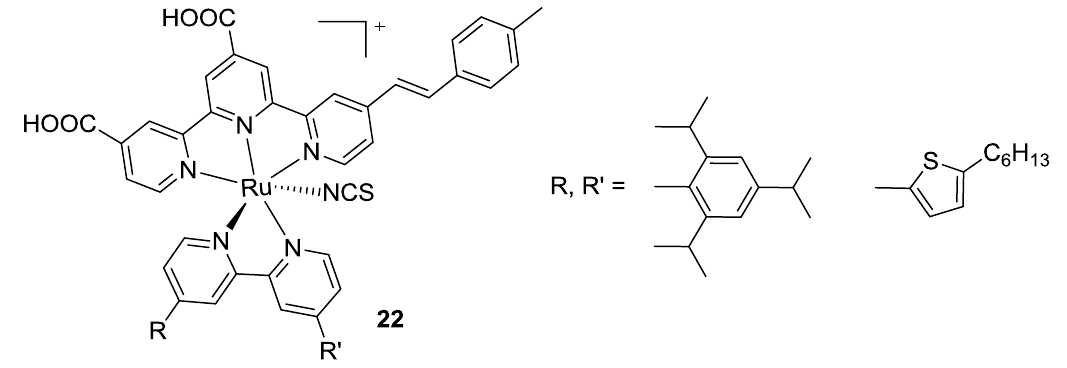
Figure 17. Ancillary ligands modifications of complex 6 [101].